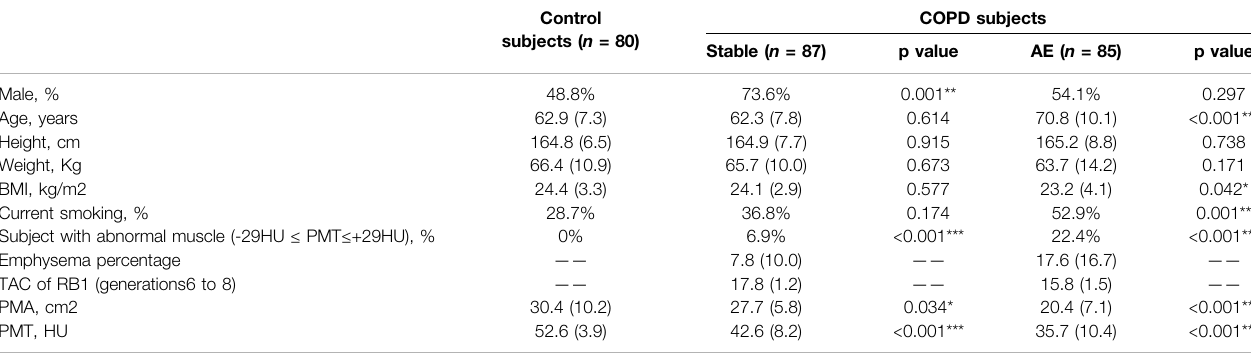
TABLE 1 | The baseline characteristics of the study population ( n = 252).